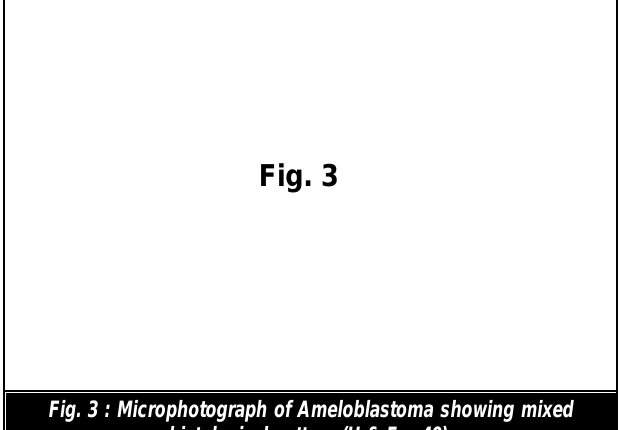
Fig. 3 : Microphotograph of Ameloblastoma showing mixed histological pattern (H & E x